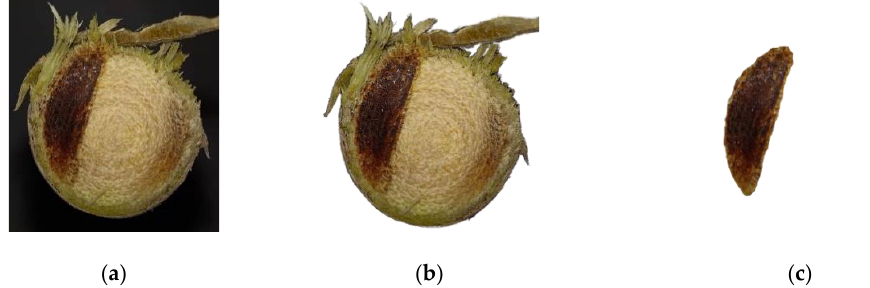
Figure 3. Extraction of branch cross-sectional area(( a ) Original image; ( b ) Extraction of branch cross-section; ( c ) Extraction of damaged parts).